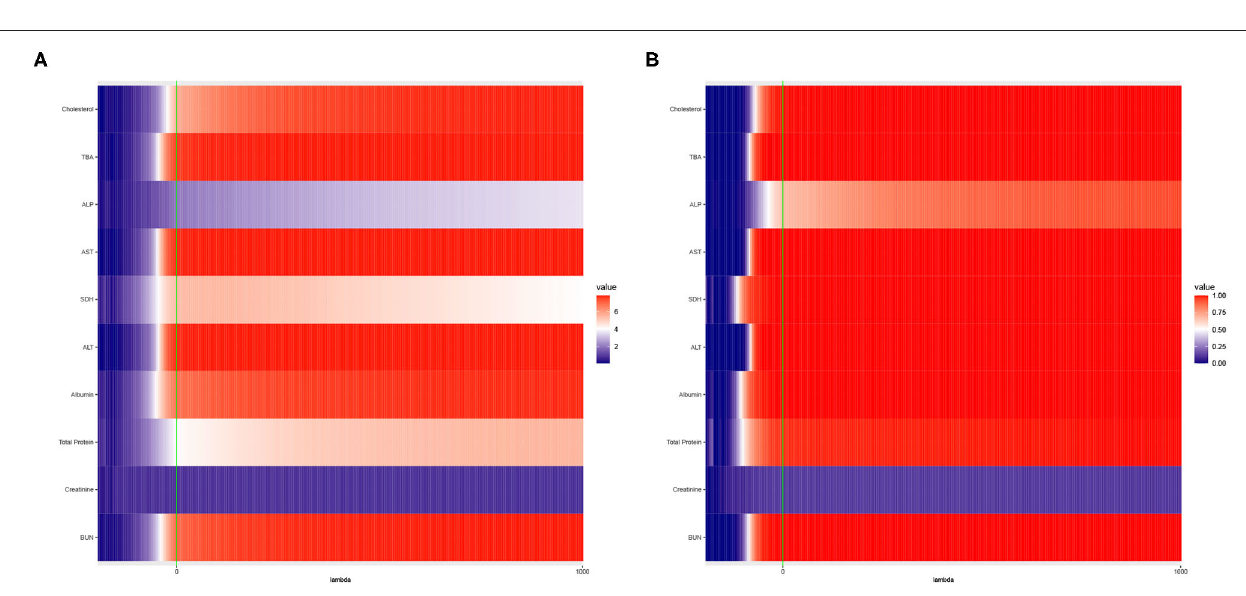
minimum eigenvalue is bounded below by a constant ℓ min